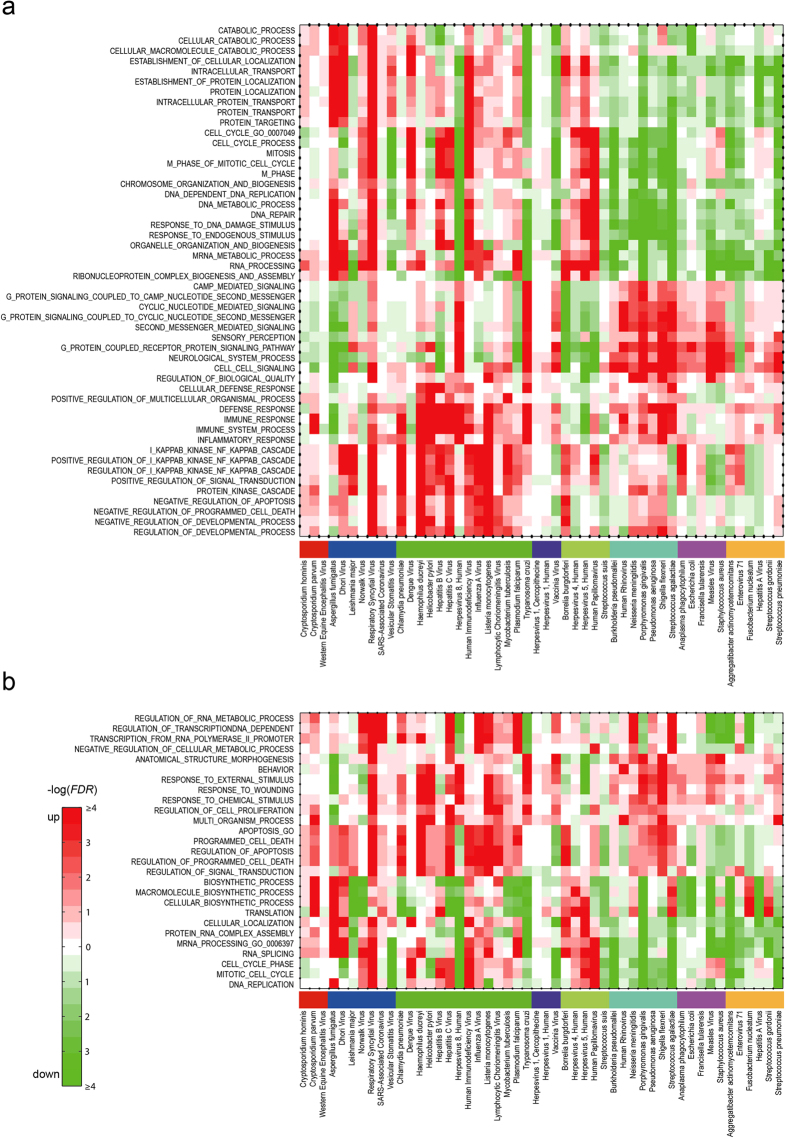
Community-specific and common bioprocesses.Heat map representation of (a) community-specific and (b) common GO BPs. GO BPs are colored according to calculated -log(FDR) values with red representing up regulation and green representing down-regulation. See Supplementary Table S5 for detailed information about community-enriched bioprocesses and Supplementary Data S6 for enrichment scores, P values, and FDR values.